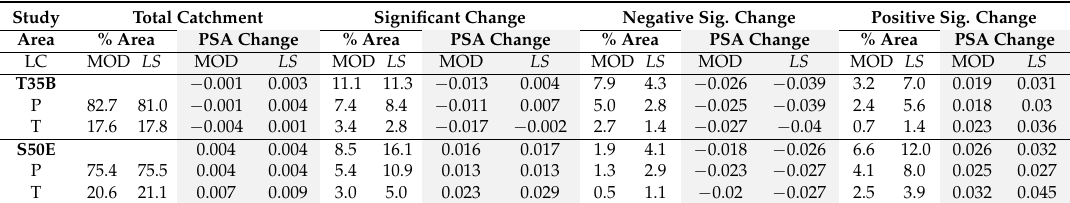
Table 5. Total and significant change in land cover classes per catchment, reported in percentage of catchment and change in albedo (highlighted in light